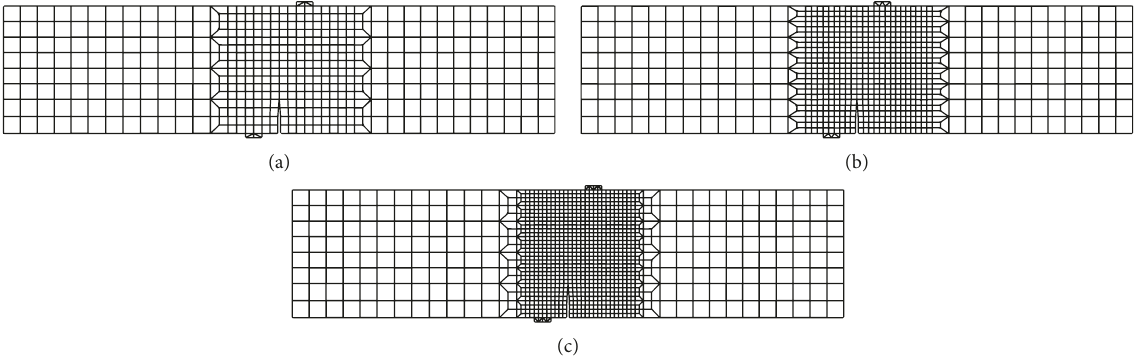
Figure 15: Different FE mesh sizes for the SEN concrete beam in the mesh-size dependency study: (a) coarse mesh; (b) medium mesh; (c) fine mesh.